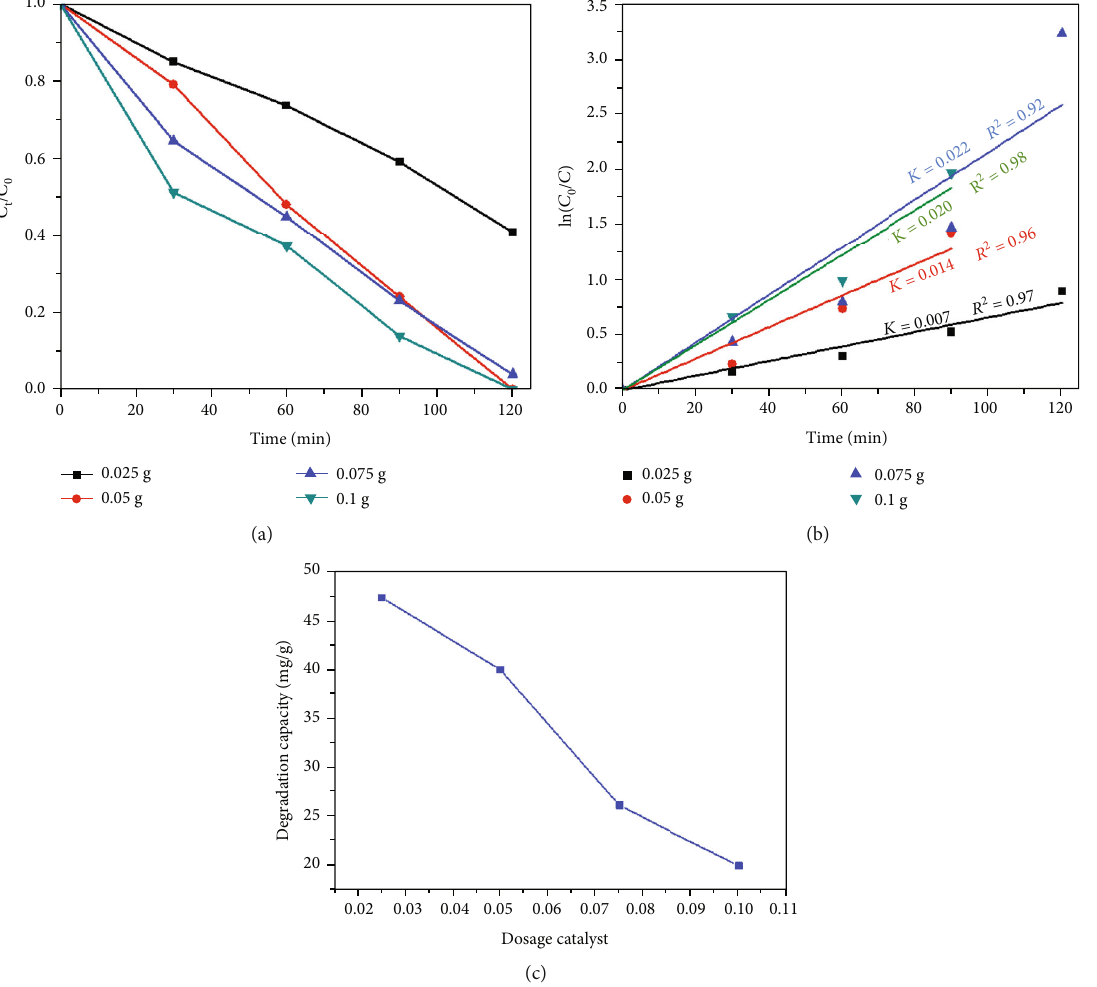
Figure 8: (a) E ff ect of dosage catalyst on photodegradation of BPA, (b) the kinetic curves, and (c) degradation capacity versus dosage catalyst. The reaction conditions are as follows: BPA concentration of 20mg/L and pH = 6 : 0